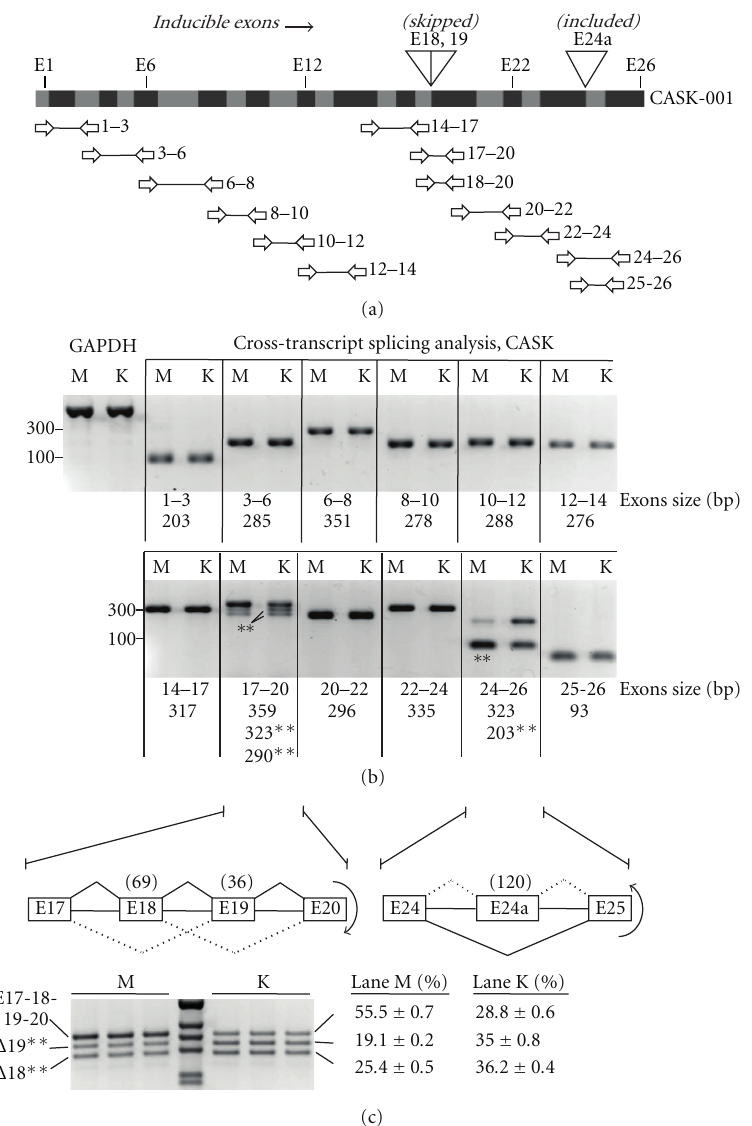
Figure 2: Splicing analysis across the CASK gene reveals three alternative exons with divergent responses to neuronal excitation. (a) Schematic (top) illustrates CASK-001 mRNA with consecutive exons represented as alternating grey and black boxes. Inducible exons identified in this study (E18, E19, E24a) are highlighted above. Horizontal arrows represent primer sets used for RT-PCR amplification of regions spanning the exon numbers at right. (b) Gel panels show results of RT-PCR to detect splicing changes from mock (lanes M) and KCl-treated (lanes K) mouse cortical neurons. Exon regions corresponding to (a) are indicated below the gel panels, and sizes of the amplified products are indicated in base pairs (bp). Asterisks ( ∗∗ ) indicate skipped products; unmarked bands represent included products. GAPDH transcripts were amplified as controls (lanes GAPDH). Fragment sizes, 300 and 100 bp (at left), were determined from a 100 kb DNA ladder. (c) Higher resolution analysis of the E18 and 19 region. Schematics represent initial splicing pattern and inducible change (curved arrows) for alternative exons of CASK. Numbers in parentheses represent exon sizes in base pairs. Gel panel shows triplicate measurements of the E17-18-19-20, the Δ 19 and Δ 18 spliced products amplified from mock (M) and KCl stimulation (K) samples. Numbers represent average % exon inclusion and standard deviations from mock (left column) and KCl (right column) datasets.